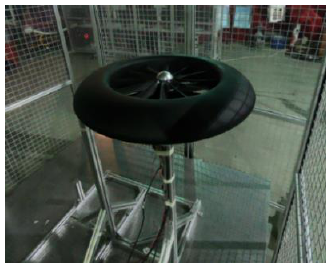
Figure 17. Test picture of the 400 ducted fan.